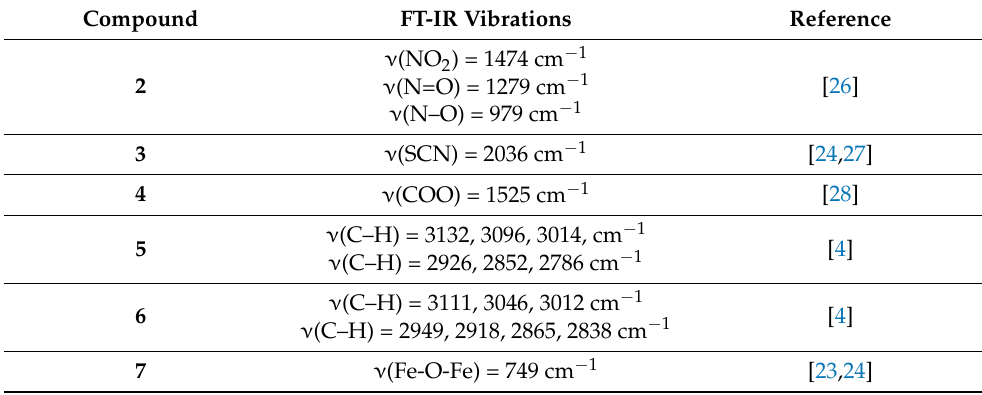
Table 1. Characteristic FT-IR vibrations of the axial ligand of compounds 2 – 7 .